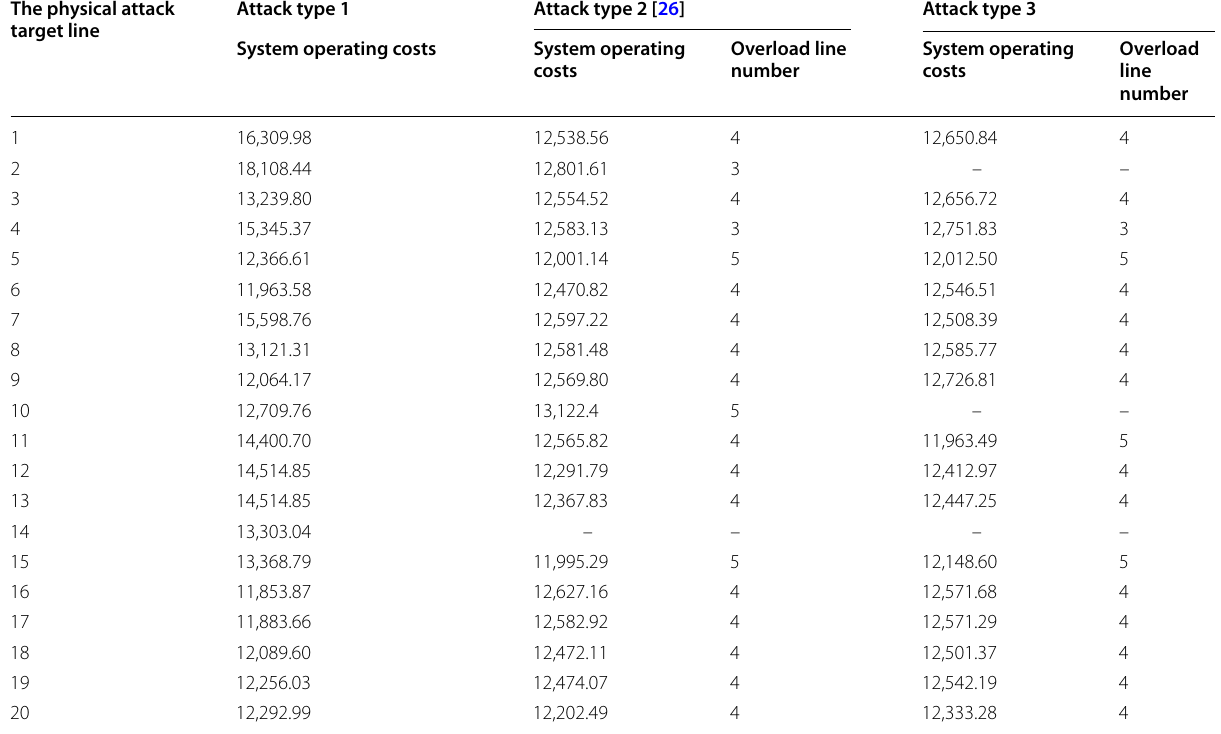
Table 3 Attack effects of different attack types The physical attack target